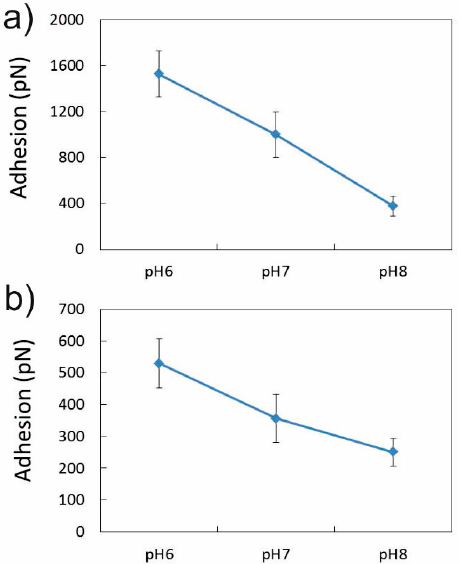
Figure 9. Graphs showing the results for experiments kao-Al-2 and kao-Al-3, where the effect of pH on the measured adhesion of a –COOH functionalised probe on the aluminol face of kaolinite was measured in the presence of a CaCl 2 concentration of 0.001 M ( a ), and a NaCl concentration of 0.001 M ( b ).